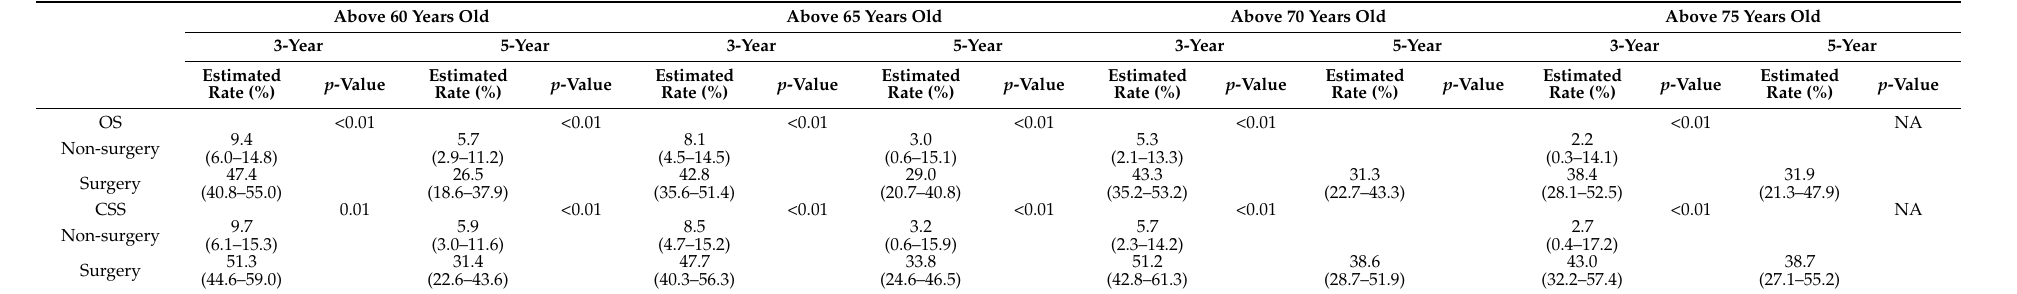
Table 3. Estimated 3-year and 5-year survival rates of surgery and non-surgery groups for M0 stage ICC patients in different age stratification.